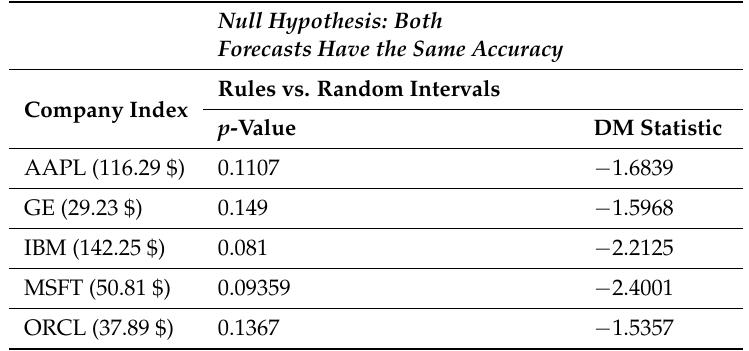
Table 7. DM-test between two forecasting models, based on SVM and using sentiments and tweets as additional features. The leftmost model is the one considering the intervals denoted by rules, while the rightmost represents the model of random intervals.